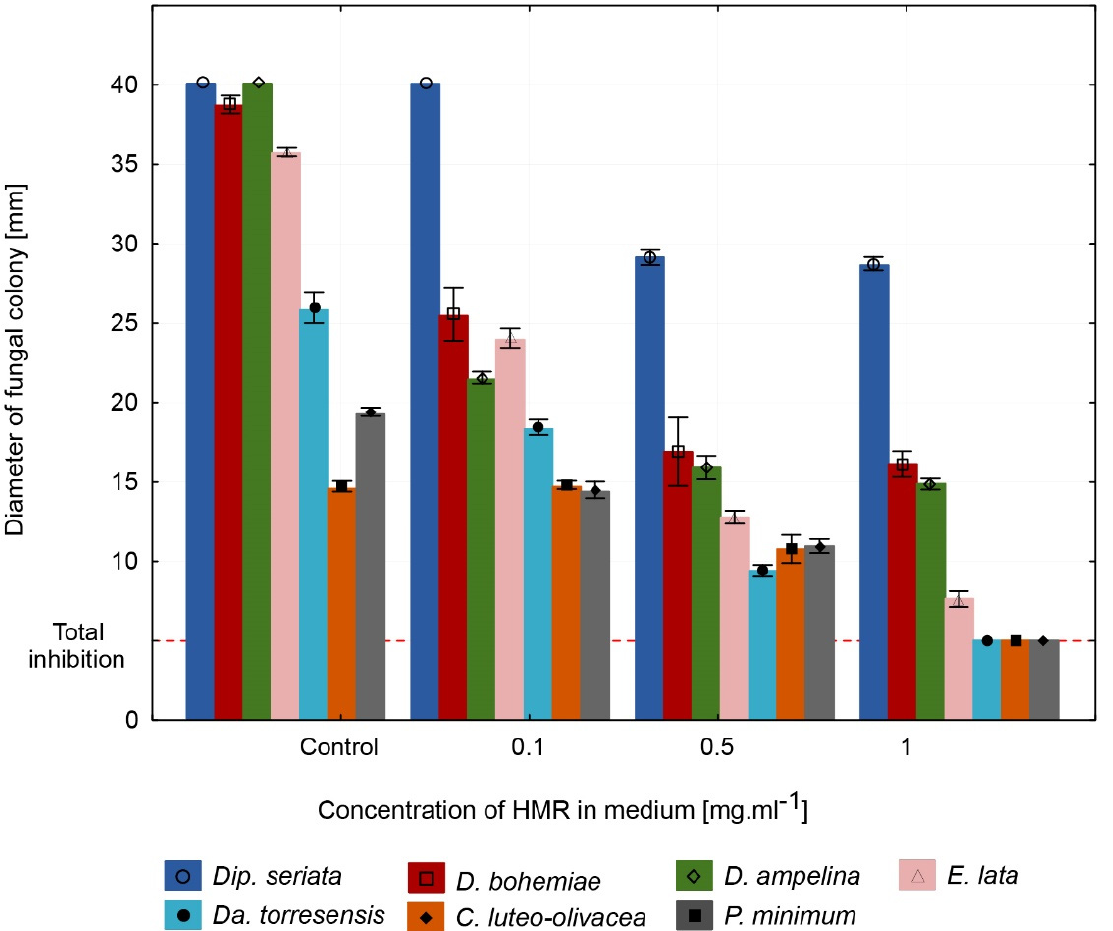
Figure 1. Antifungal effect of GE after 5 days of cultivation for all tested fungi except P. minimum and C. luteo-olivacea, which were measured after 10 days. A colony diam. of 5 mm was considered to be a total inhibition of growth, since it was the size of the inoculation disk.